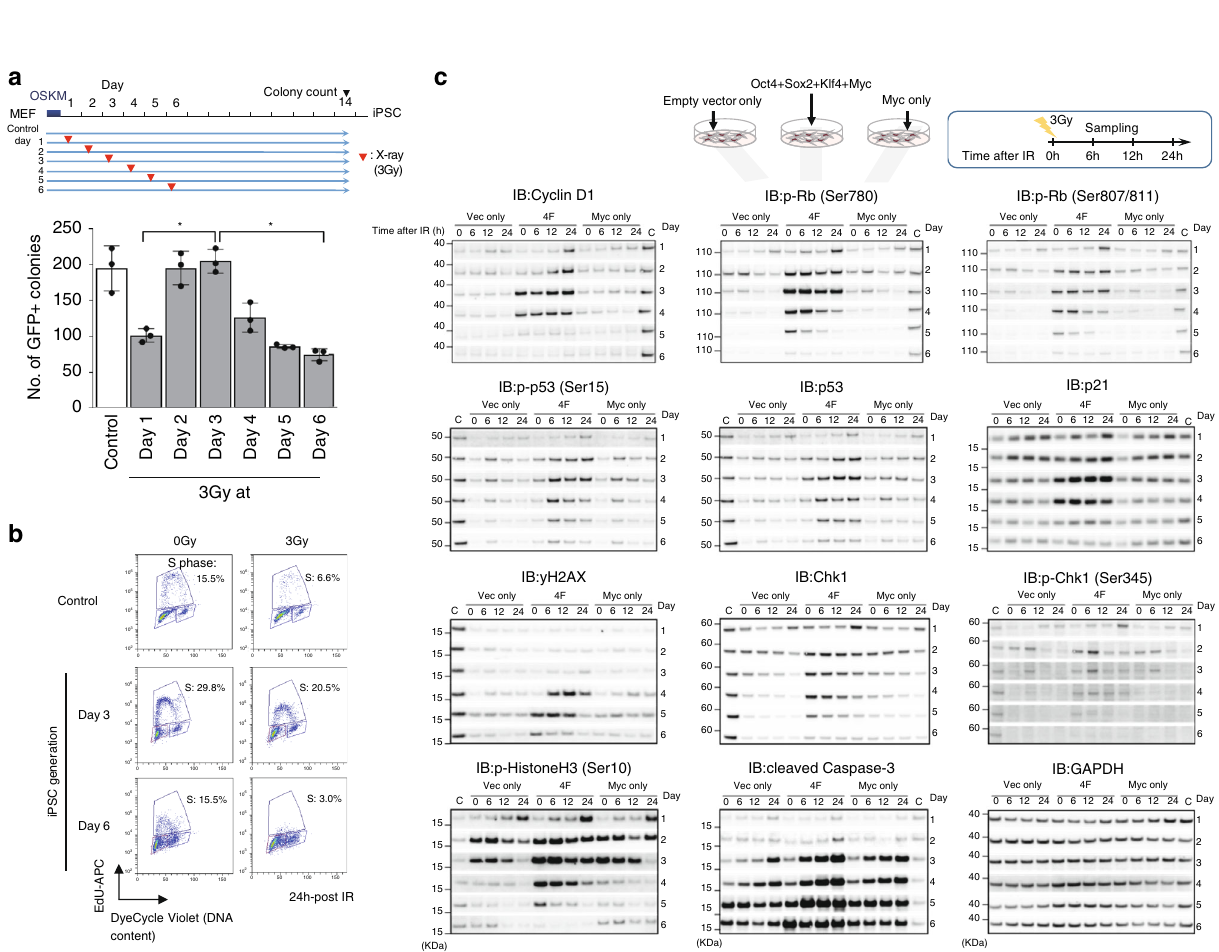
Fig. 2 Pluripotency and differentiation ability of iPSCs derived from CB-erythroblasts. a Con fi rmation of an integration-free status in the established iPSCs. The positions of the PCR amplicons for OriP, EBNA1, and hygromycin in the plasmid are shown in Supplementary Fig. 2a. Template mixtures, 10 copies of pEB-C5 vector/cell, and one copy of pEB-C5 vector/cell, were used as positive controls. Genomic DNA corresponding to ~10,000 cells was used in each sample, β -globin was used as the control for the presence of genomic DNA. b Immunocytochemical staining of stem cell markers is shown with Hoechst33342 counterstaining (bottom of each panel). Scale bar, 100 μ m. c Immunocytochemical staining of tissue-speci fi c markers was conducted to assess the abilities of the iPSCs to differentiate into three germ layers. β III-tubulin, alpha-fetoprotein (AFP), and α -smooth muscle actin ( α SMA) were used as markers of ectoderm, endoderm, and mesoderm, respectively. Hoechst33342 counterstaining is also shown. Scale bar, 200 μ m (EB) and 100 μ m (immuno fl uorescence). EB, embryoid body.